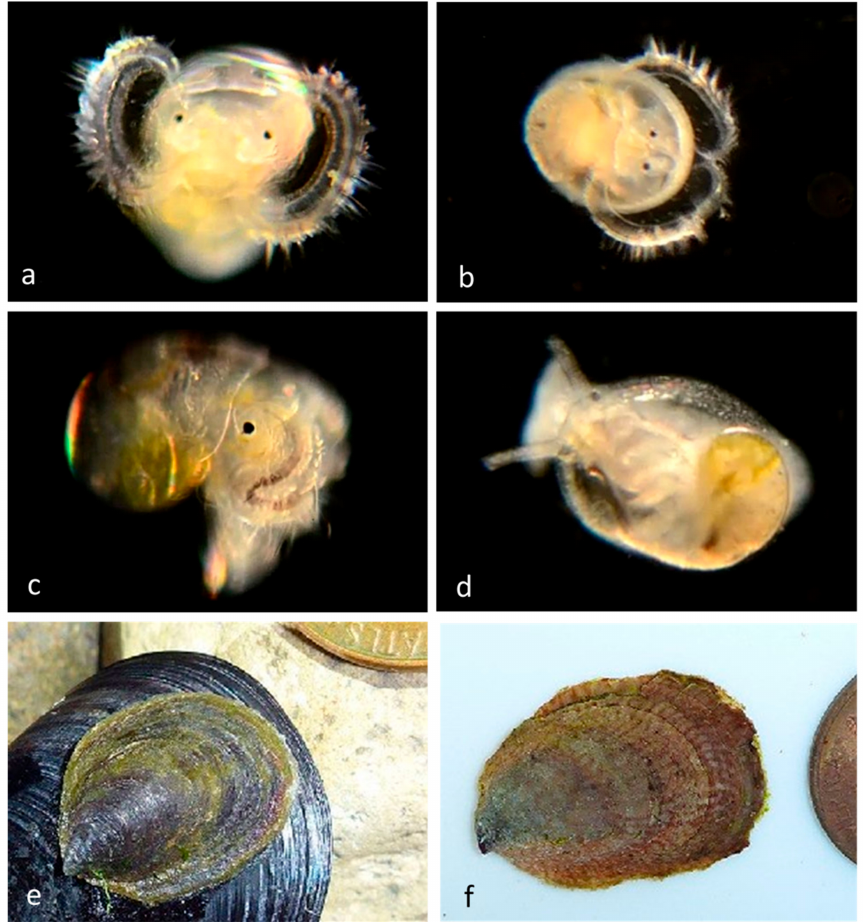
Figure 4. Family Calyptraeidae. Onyx slipper snail , Crepidula onyx . ( a ) Veliger BIOUG01229-H01 from off Newport Pier. ( b ) Veliger BIOUG01229-B01 from off Newport Pier. ( c ) Late veliger CCDB 31597 F09 from Newport Harbor entrance. ( d ) Juvenile BIOUG01205-D02 from off Newport Pier. ( e ) Adult CCDB-32336 D06 from Balboa at Coral. ( f ) Adult CCDB-32336 E12 from Dana Point south shore. Our adult specimens of Crepidula huertae , (Figure 6) found inside the empty shell of a Bubble Snail ( Bulla gouldiana ) from Balboa at Coral (Newport Harbor), supported by the presence of DNA-sequenced veligers at the Harbor Entrance, extend the host and geographic range of this species, which was otherwise known from hermit crab shells at Naples Reef, near Santa Barbara, Santa Barbara County, California [10].